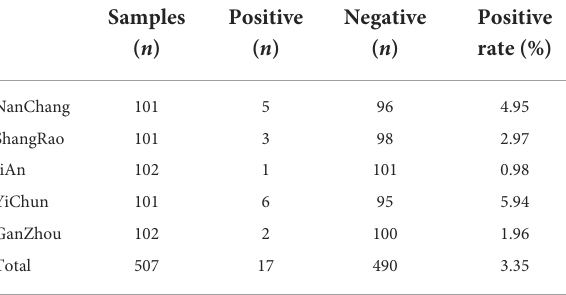
TABLE 4 The Cap antibody detection results by the ELISA from 507 serum samples.